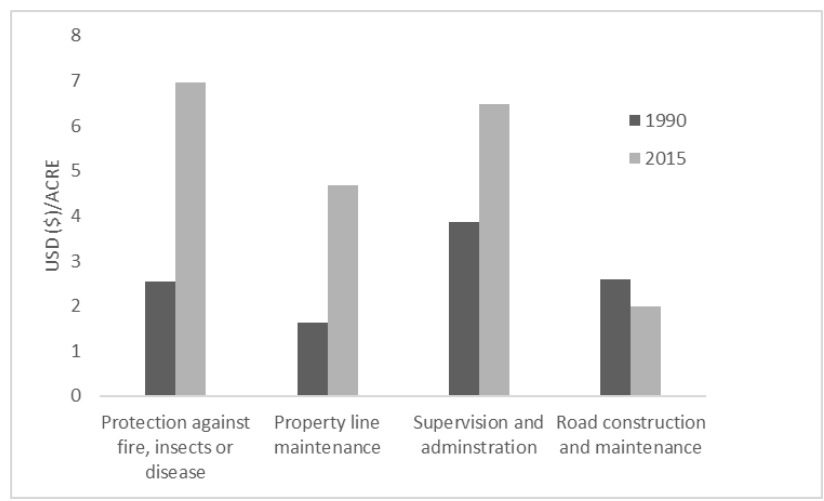
Figure 8. Mean expenditures for Other Management Activities of landowners who incurred expenses .